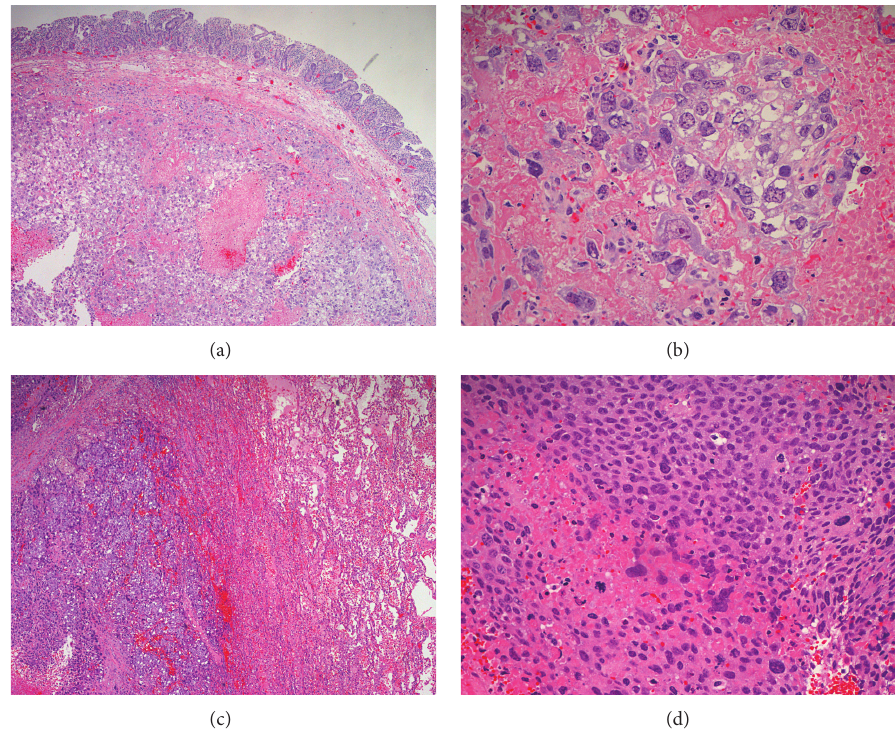
Figure 2: (a) Denuded small bowel mucosa overlying clusters of tumor cells with foci of hemorrhage and necrosis. (b) The tumor in small bowel composed predominantly of mononuclear cytotrophoblasts with clear cytoplasm, distinct cellular borders, and centrally located vesicular nuclei with prominent nucleoli. (c) Lung parenchyma (right) with adjacent nests of high-grade tumor cells (left) and hemorrhage. (d) Tumor cells from lung showing a mixture of mononuclear cytotrophoblasts and multinucleate syncytiotrophoblasts.